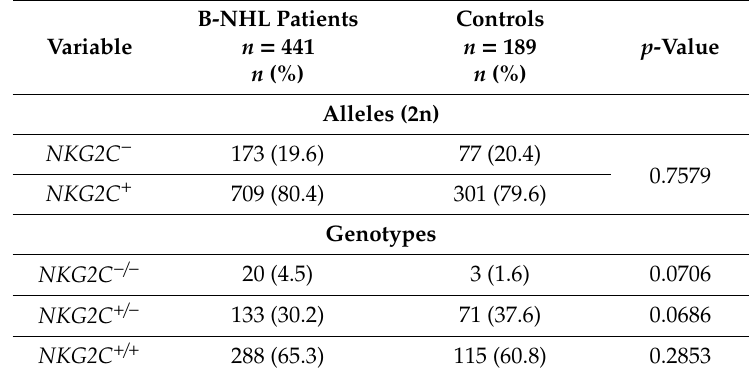
Table 1. Distribution of NKG2C allelic and genotype frequencies of B-cell non-Hodgkin lymphoma (B-NHL) patients and healthy controls. The NKG2C homozygous deletion allele frequencies and genotype frequencies did not di ff er among B-NHL patients and healthy controls.